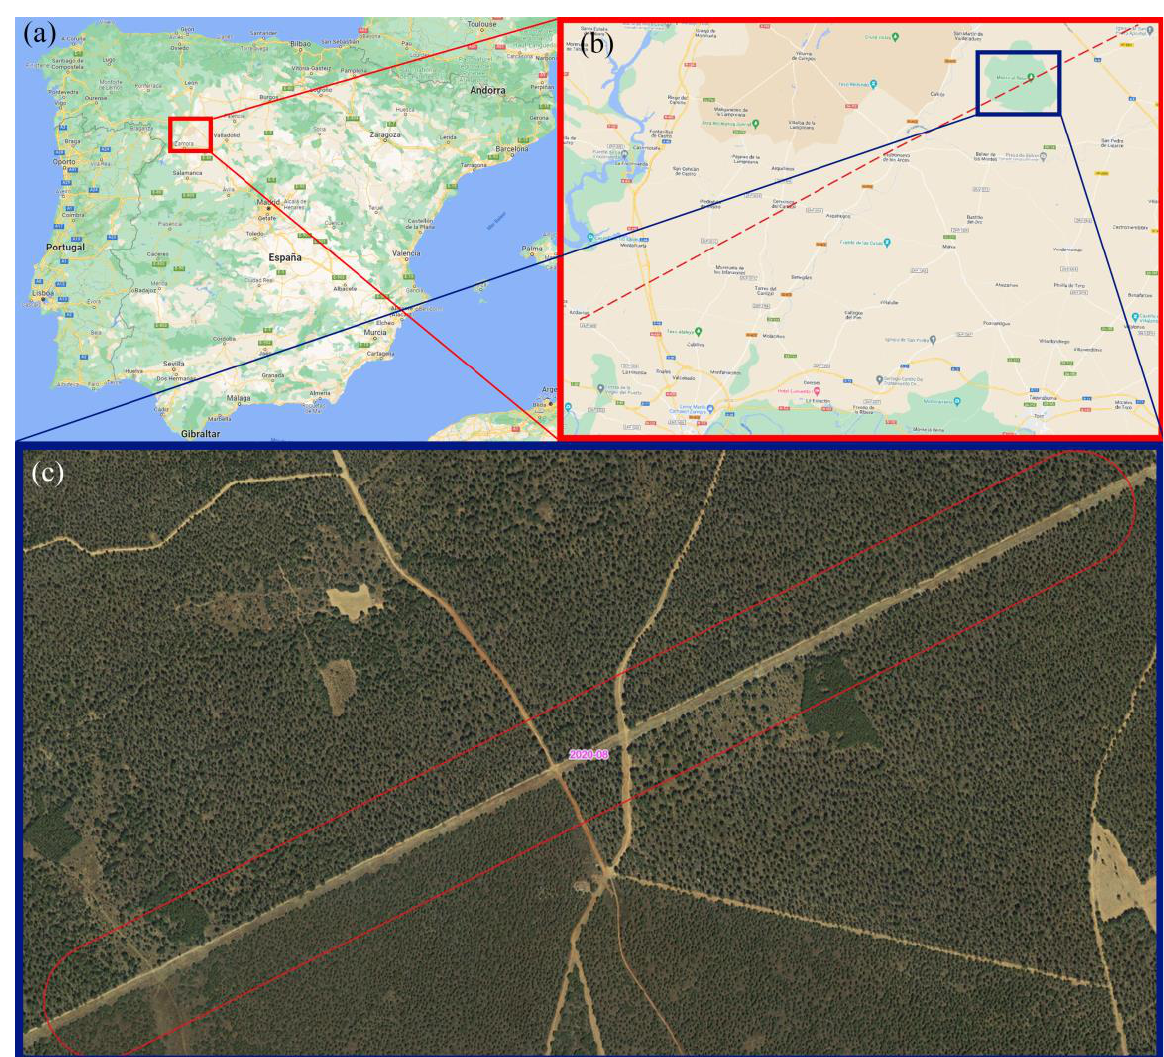
Figure 7. Study area to validate the proposed methodology. ( a ) Location map in Spain; ( b ) situation of the power line in the province of Zamora (Spain); ( c ) selected area for the drone flight.